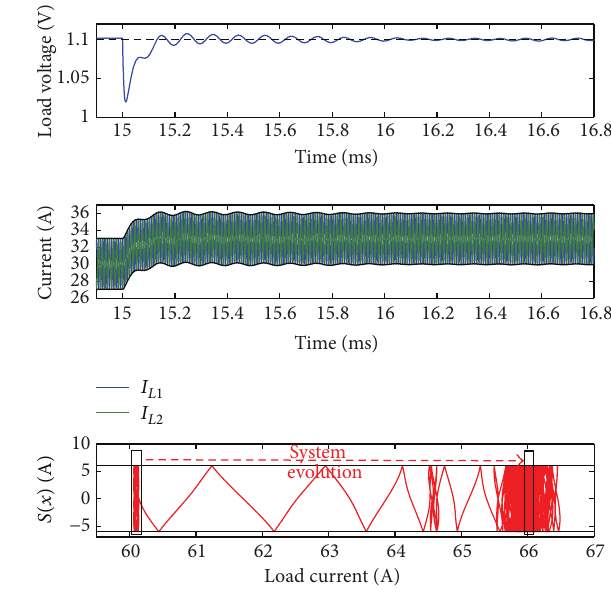
Figure 10: Output voltage ripple comparison between BuckS and BuckPS.